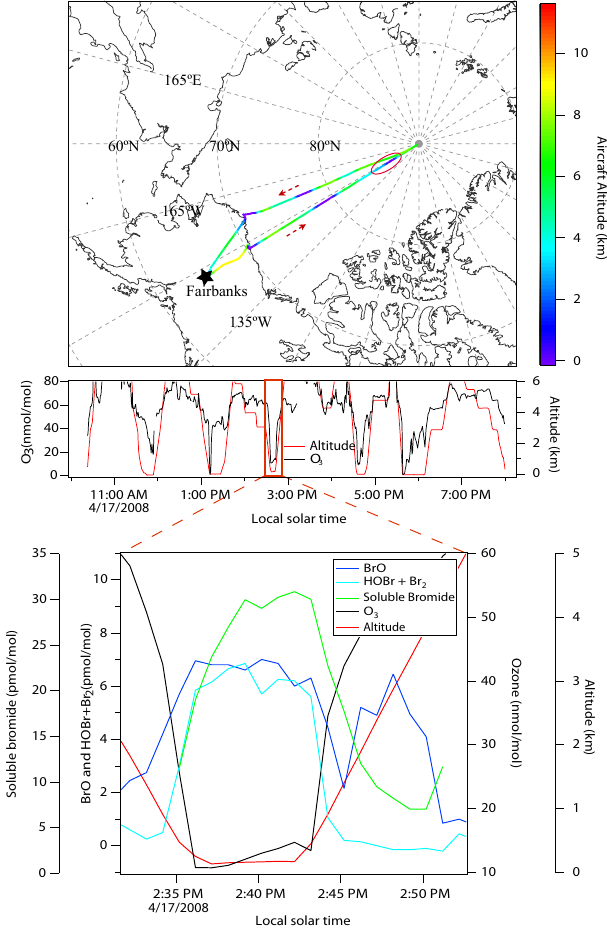
Fig. 2. Top panel: The flight track of the NASA DC-8 on 17 April 2008 color-coded with aircraft altitudes. The black star denotes the beginning of the flight and the dashed arrows represents the direc- tion of the flight. The red circle shows the location on the flight track that corresponds to the bottom panel. Middle panel: Time series of observations of ozone and altitude. Bottom panel: Obser- vations of soluble bromide, BrO, lower limit of Br 2 +HOBr, O 3 and altitude for the flight leg with the highest levels of bromine.